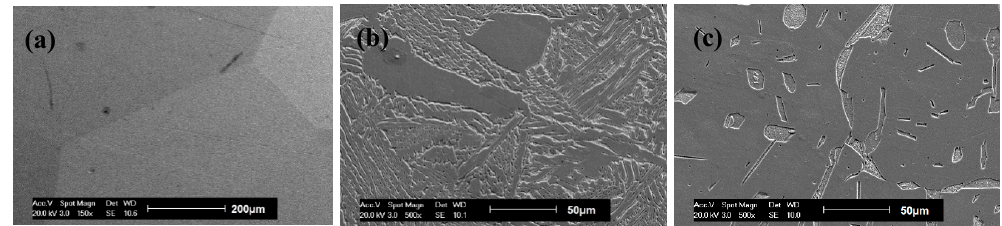
Figure 2. Scanning electron microscope (SEM) micrographs of longitudinal sections showing the microstructures of ( a ) CuZn42 (CW510L), ( b ) CuZn38As (CW511L), and ( c ) CuZn36 (C27450), after selected heat treatment conditions.